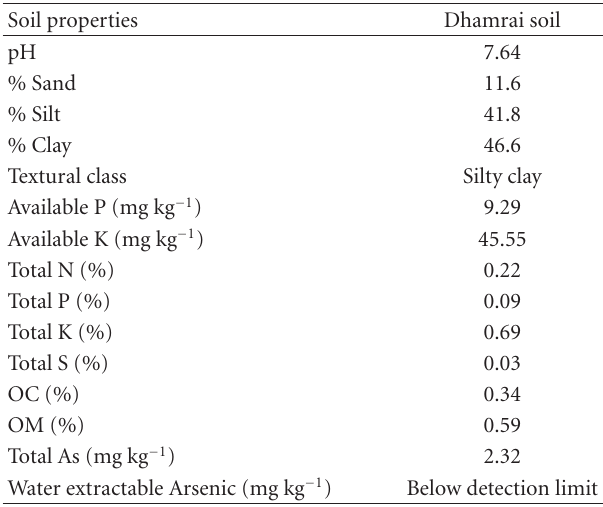
Below detection